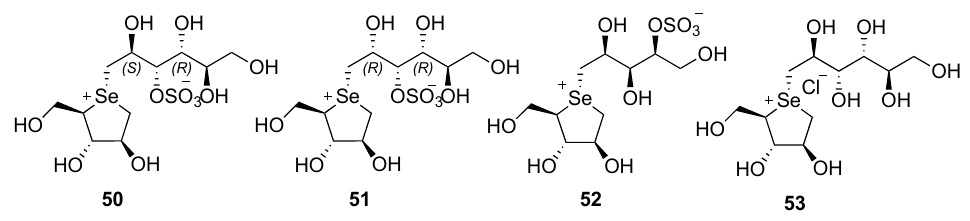
Figure 5. Structures of selenosugars 47–49 .